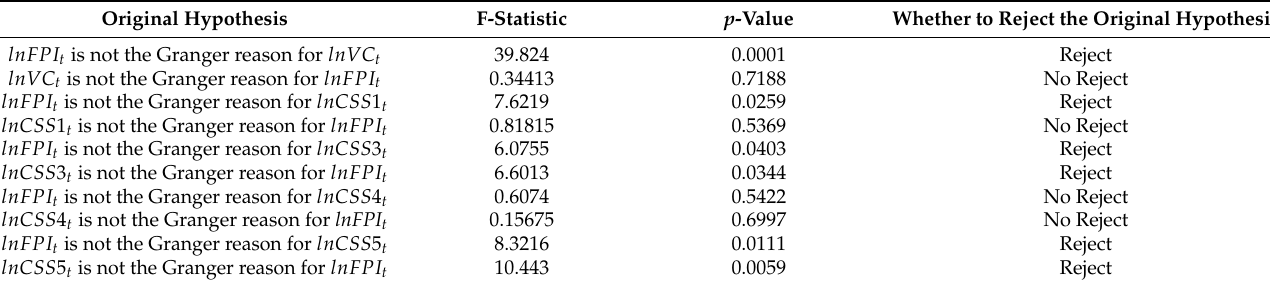
Table A5. Results of the Granger causality